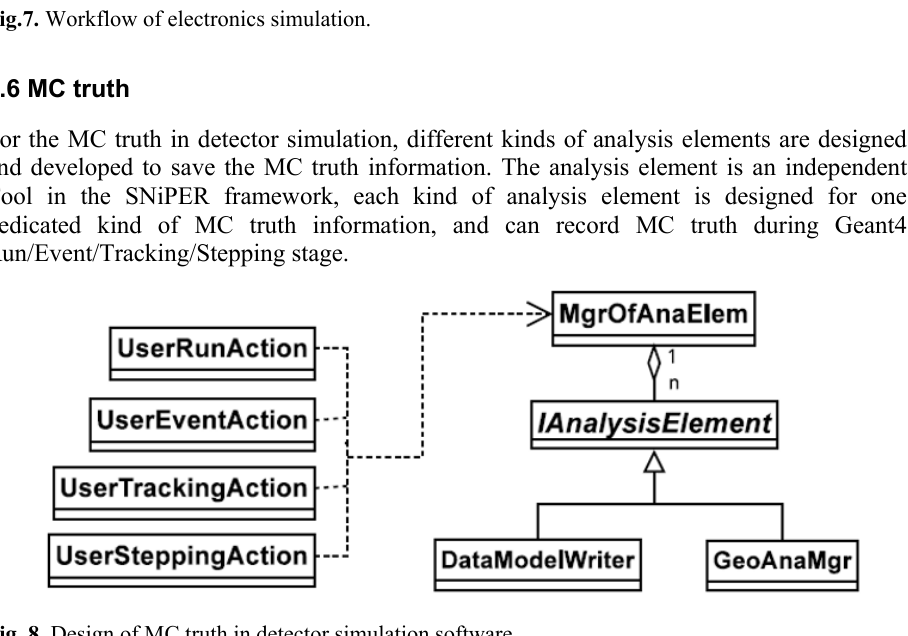
Fig. 8. Design of MC truth in detector simulation